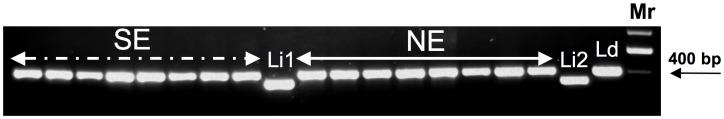
Characterization of Ethiopian parasite strains from patients with visceral leishmaniasis by short cpbE/F - PCR.Amplicons were separated by electrophoresis on 2% agarose gel and staining with ethidium bromide. Reference DNA samples for Leishmania infantum are indicated by Li1 (MCAN/IL/2000/LRC-L792) and Li2 - (MHOM/TN/1980/IPT1), and for L. donovani by Ld (MHOM/SD/1962/1S cl2). Mr −100 bp molecular weight marker. Representative parasite DNA samples examined by short cpbE/F - PCR from left to right Southern Ethiopia (SE): AM546, AM548, AM551, AM552, AM553, AM554, AM560, AM563 and Northern Ethiopia (NE): GR284, GR353, GR356, GR358, GR361, GR378, GR379, GR383.